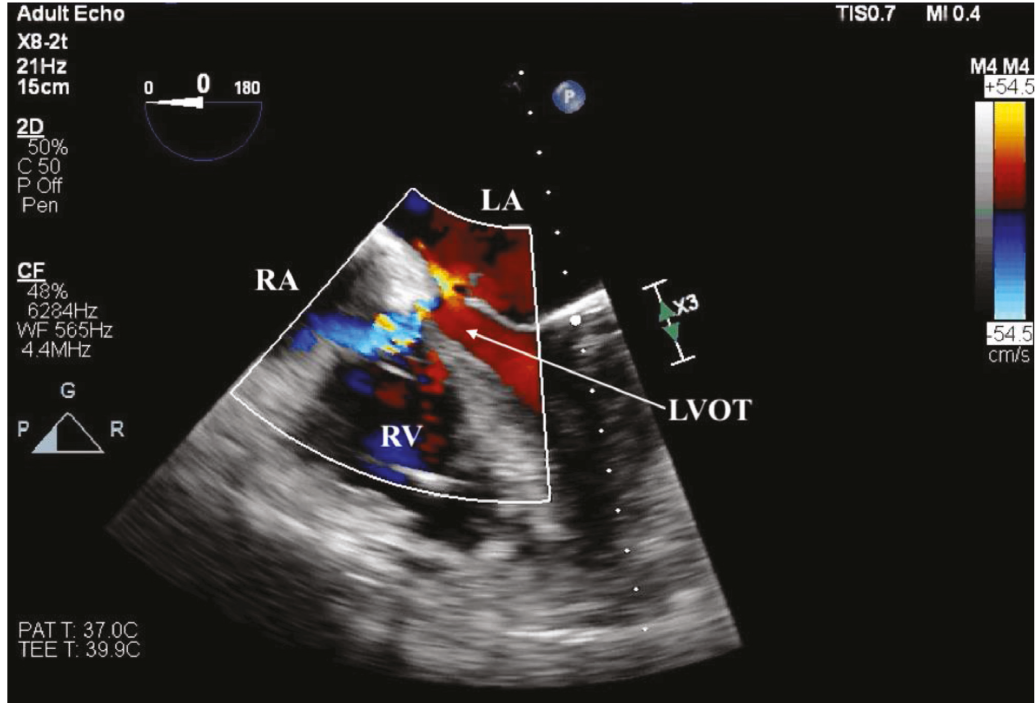
Figure 2: 2D mid-esophageal four-chamber view with CFD demonstrating biatrial regurgitant jets originating in the LVOT and occurring into diastole (Philips X8-2t probe, Cambridge, MA).